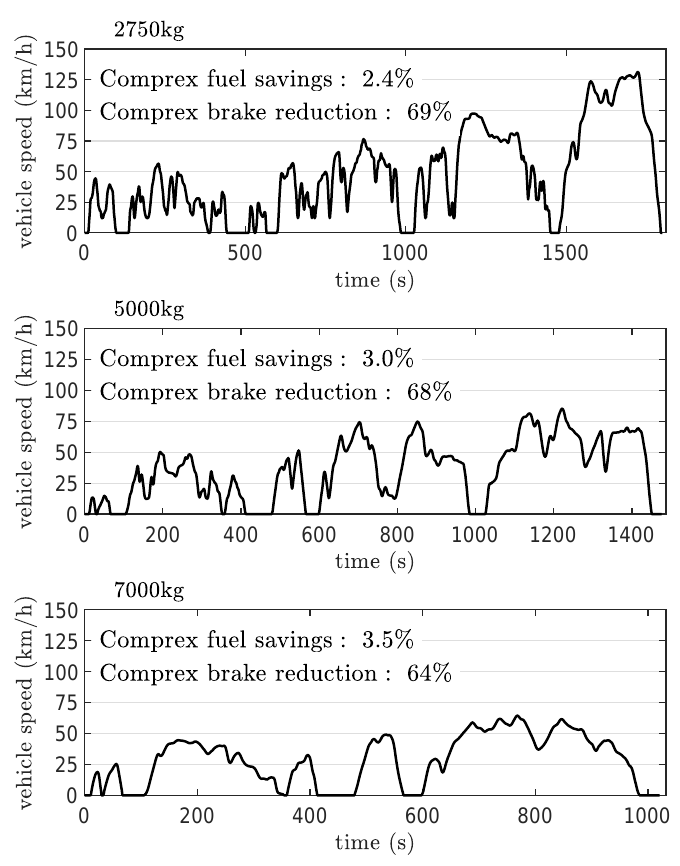
Figure 14. WLTP driving cycles for different vehicle weights (different power-to-weight ratios). The Comprex/Miller concept enables fuel savings for all three driving cycles/vehicle weights and also a reduction of the energy dissipated in the friction